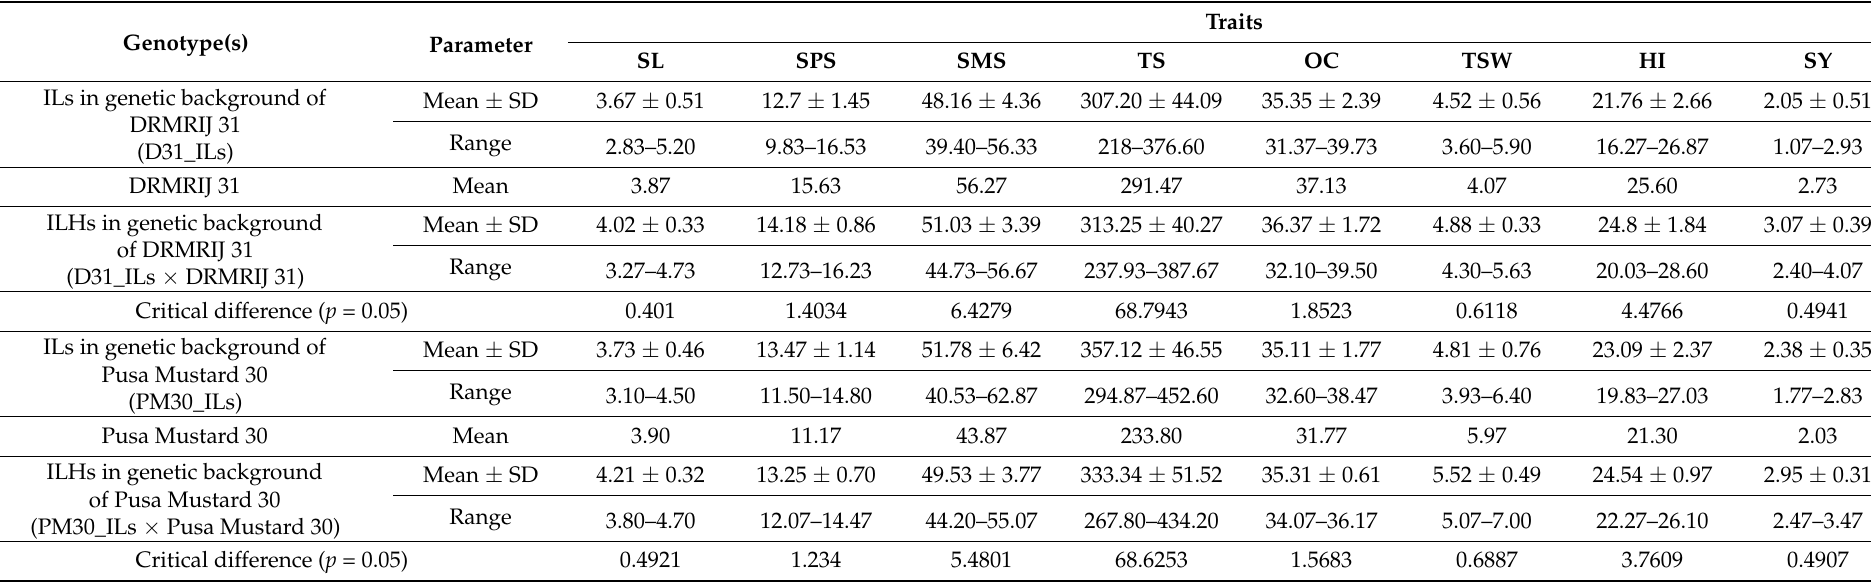
Table 1. Mean and range for seed yield and its contributing traits among genetic backgrounds, introgression lines (ILs) and introgression line hybrids